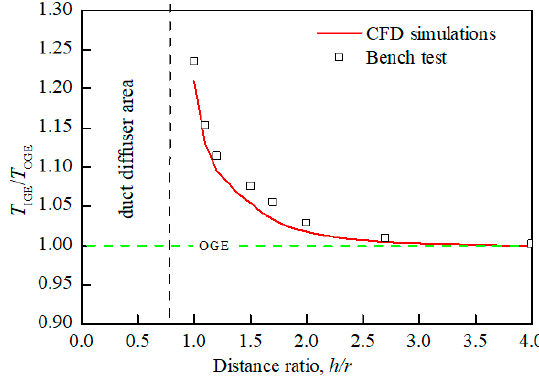
Figure 9. Lift ratio of ground effect by CFD simulations.